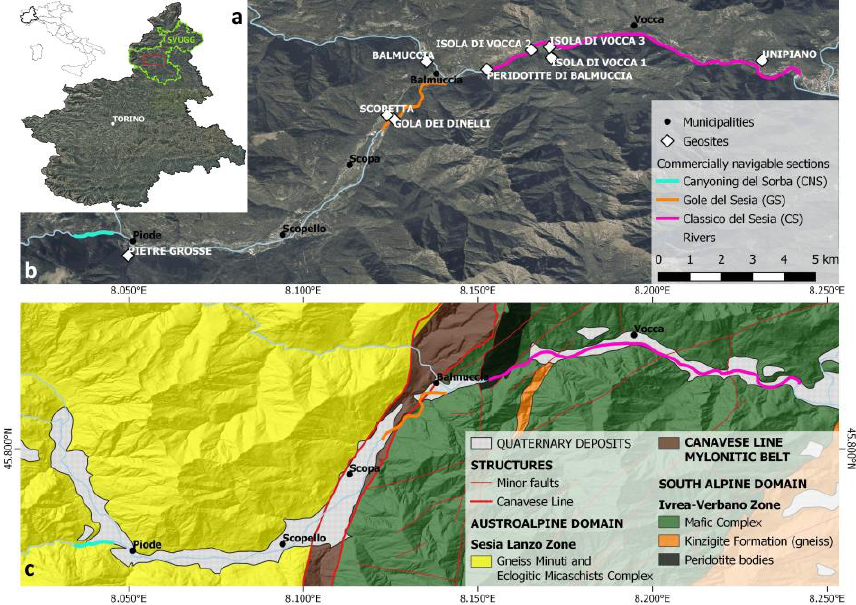
Figure 2. Maps showing: ( a ) the location of the study area (red rectangle), with respect to the Sesia Val Grande UGGp (shape in bright green), Piemonte region, and Italy; ( b ) the commercial navigable segments of the Sesia River and Sorba Stream in the Sesia Valley; ( c ) the geological map of the investigated river segments.